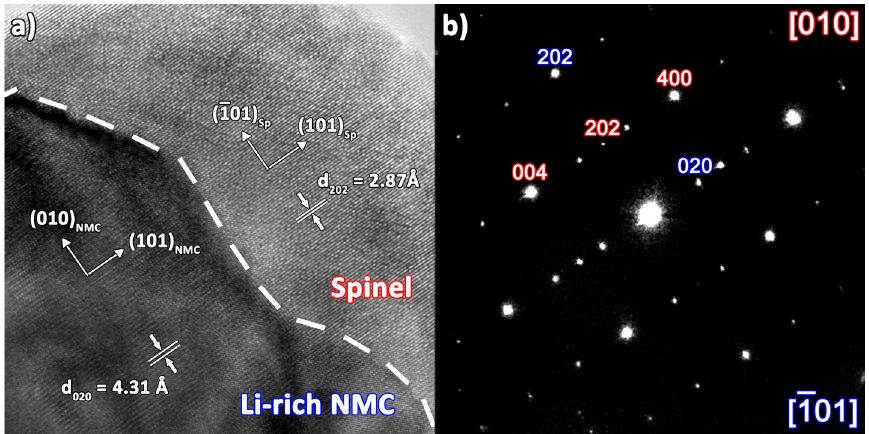
Figure 4. ( a ) HRTEM image of the surface of Li 4/3- x Ni 2+ x Mn 4+2/3- x Co 3+ x O 2 (Li-rich NMC) particle covered with the LiMn 1.5 Co 0.5 O 4 spinel layer. The dashed line marks the boundary between the layered phase and spinel. The directions in the crystal lattice for each phase are indicated by arrows. Major interplanar distances are marked. ( b ) Electron diffraction(ED) pattern corresponding to the area shown in the panel ( a ). The reflections are indexed as belonging to the layered phase (blue) and spinel (red) structures, the zone axes are also identified and given in corresponding colors.